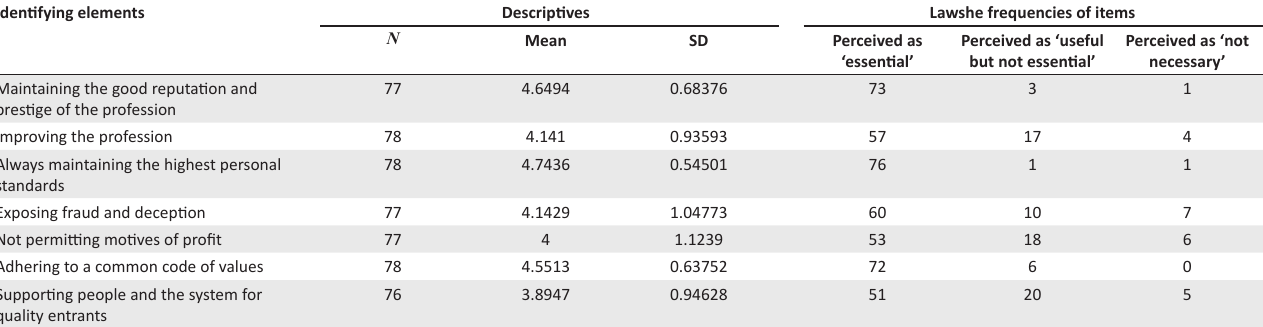
TABLE 7: Descriptive statistics of responsibility towards profession. Identifying elements